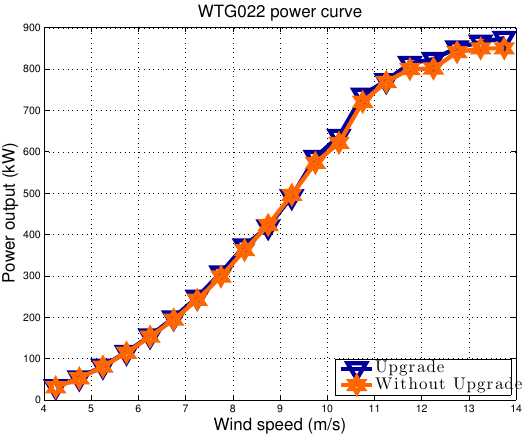
Figure 12. WTG022 power curve during D aft .